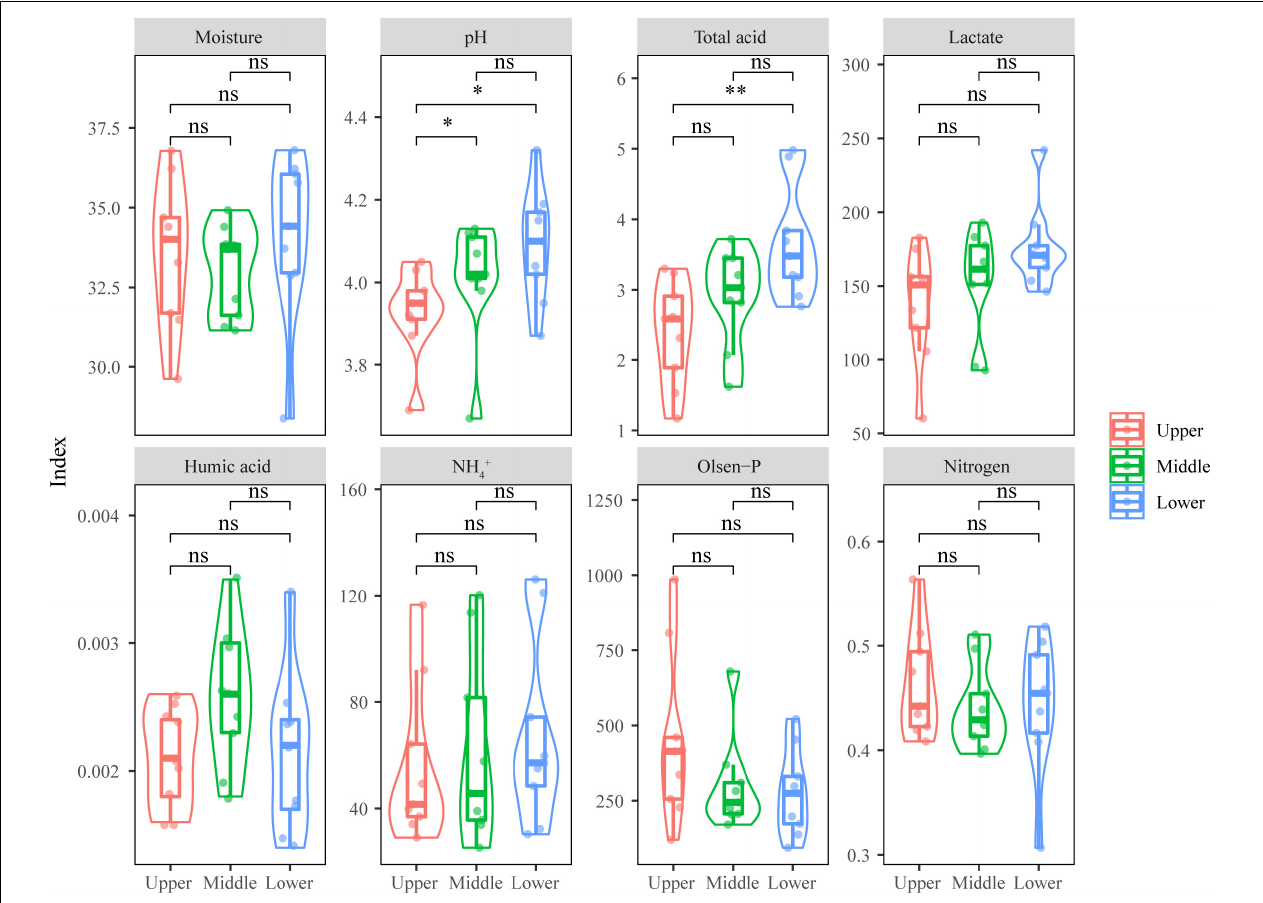
FIGURE 1 | Physicochemical indicators of PM samples at different depths. Significant difference is represented by ∗∗ (0.001 ≤ p < 0.01), ∗ (0.01 ≤ p < 0.05), and ns ( p ≥ 0.05),